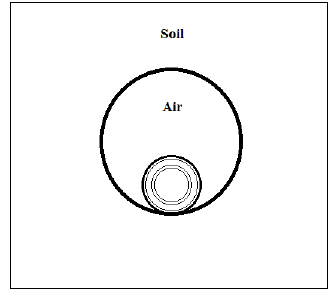
Figure 3. A single cable in directly buried